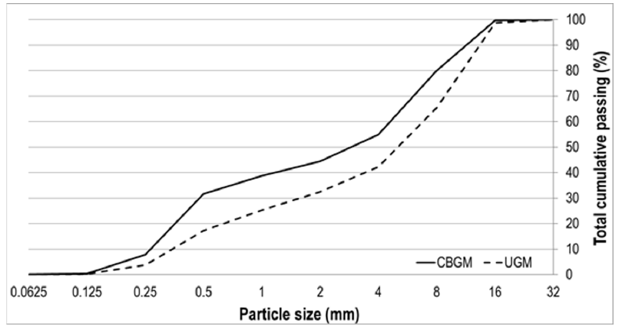
Figure 1. Grain size distribution of used natural aggregates.